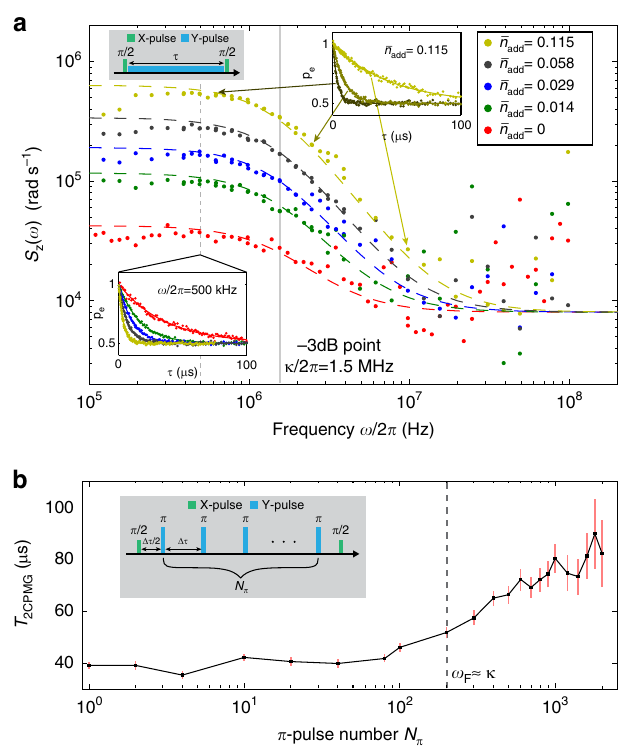
Figure 6 | PSD of photon fluctuations in the resonator. ( a ) Noise power spectral densities (PSDs) extracted from spin-locking ( T 1 r ) relaxation experiments (Inset, top-left: T 1 r pulse sequence) measured for different locking (Rabi) frequencies (0.1–100MHz) and added noise photons (cid:2) n add . Coloured dashed lines indicate expected lorentzian noise spectra (see equation (6)) assuming a constant white-noise offset. The vertical grey line indicates the 3-dB point of the lorentzians, coinciding with the resonator decay rate k /2 p ¼ 1.5MHz. Inset, bottom-left: T 1 r decay traces for different photon populations at fixed locking (Rabi) frequency o /2 p ¼ O R / 2 p ¼ 500kHz. Inset, top-right: T 1 r decay traces at different locking (Rabi) frequencies for n add ¼ 0.115. ( b ) Decay times T 2CPMG for the CPMG sequence measured versus number of p -pulses, N p , with n add ¼ 0 (no added noise photons). The CPMG pulse sequence (inset) acts as a bandpass noise filter centred at a frequency proportional to N p through the pulse spacing D t (see main text). At N p ¼ 200, the filter frequency approximately equals the cavity decay rate (dashed line). For N p o 200, the filter samples the flat low-frequency portion of the lorentzian PSD, yielding a constant decay time T 2CPMG E 40 m s. For N p 4 200, the filter traverses the roll-off region of the lorentzian. As the sampled noise decreases, the decay times increase, approaching the limit set by energy relaxation ( T 2CPMG E 2 T 1 ) for N p 4 1,000. Error bars indicate 95% confidence intervals on the fitting algorithm used to extract these level decreases, T 2CPMG rises. For N p 4 1,000, the refocusing correspondence between the noise spectral density in Fig. 6a and the mitigation of that noise by CPMG in Fig. 6b strongly supports our methods and interpretations.